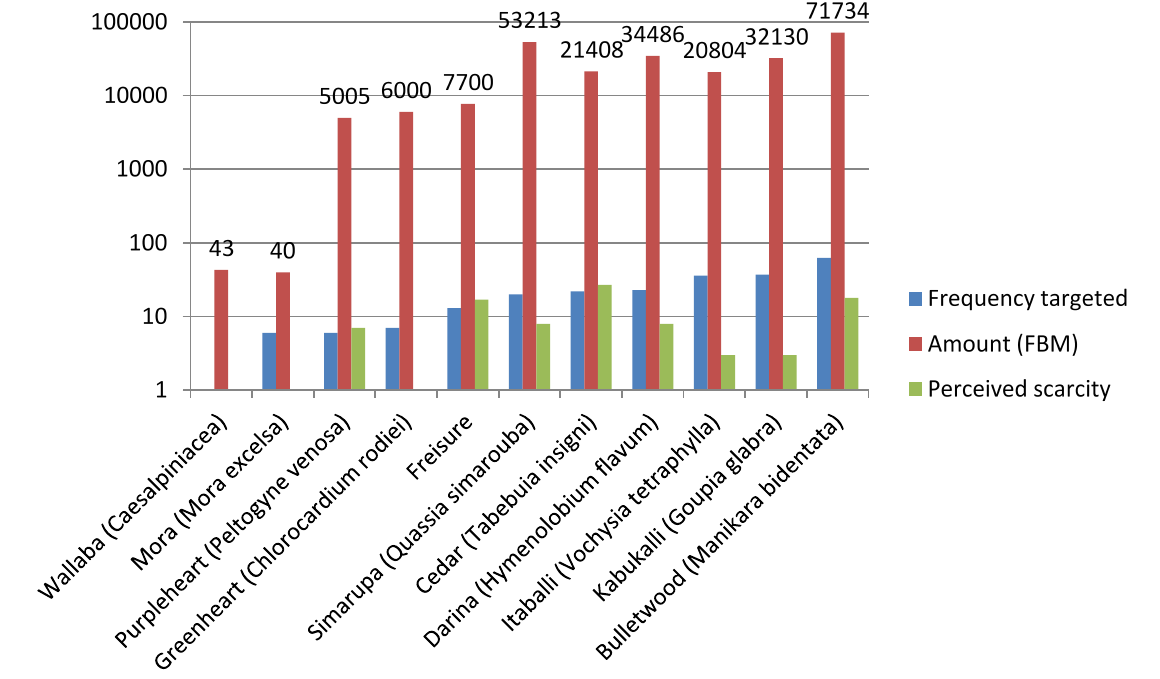
Figure 7. Extraction trends and amounts in FBM (1 month) in the Annai